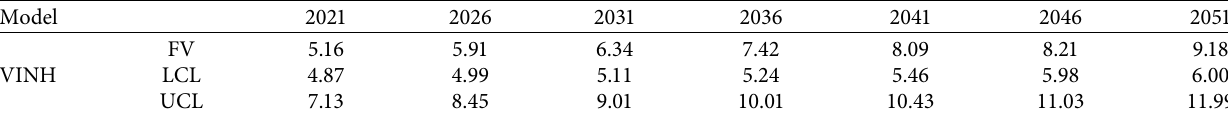
Table 6: Time-series forecast table.